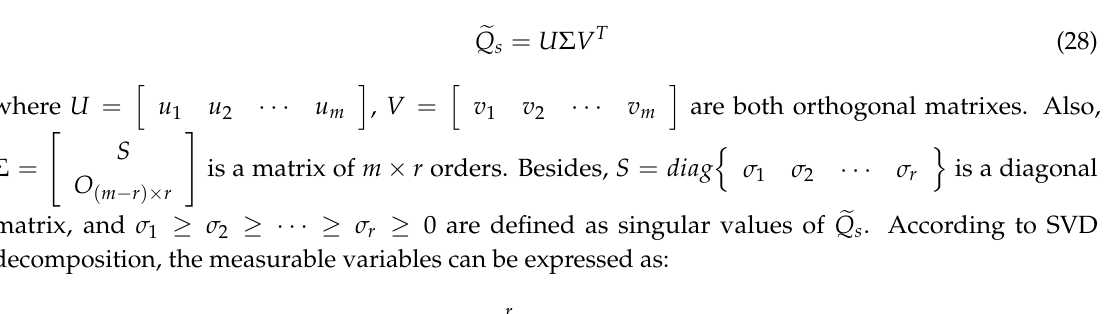
Figure 6. Vehicle trajectory. 0